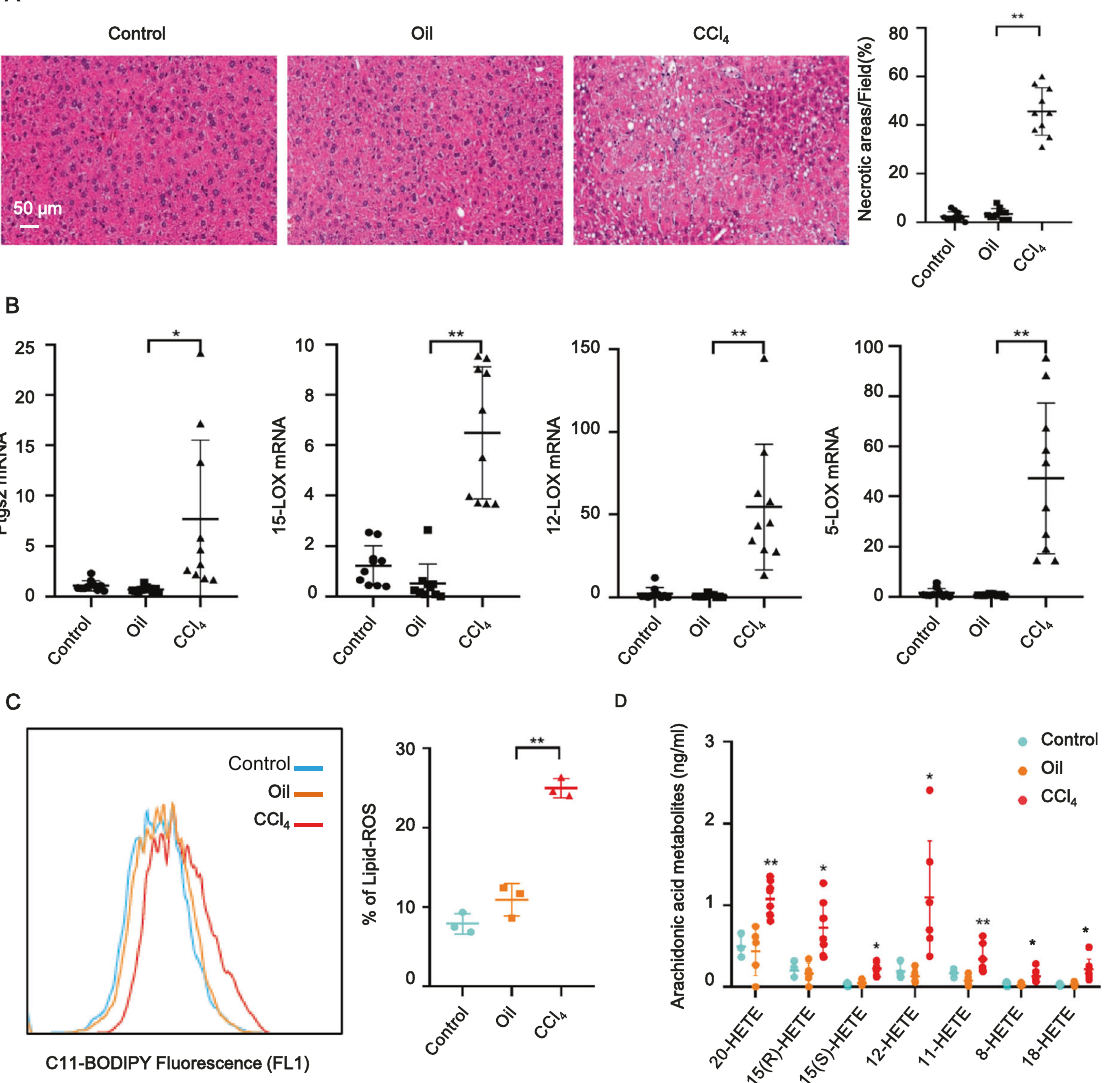
Fig. 1 Ferroptosis occurred in livers of ALI mouse models. A Hematoxylin and eosin (HE) staining showed that administration of CCl 4 induced ALI in mice. B Ptgs2, 15-LOX, 12-LOX , and 5- LOX mRNA levels were measured in livers of 8-week-old male C57BL/6 mice treated for 6 h with or without CCl 4 . mRNA levels were normalized to that of GAPDH and were expressed relative to the mean value in the PBS-treated mice. C Lipid peroxidation was measured using C11-BODIPY 581/591 staining. D Ultra-performance liquid chromatography-tandem mass spectrometry (UPLC-MS/MS) analysis of 20-hydroxyeicosatetraenoic acid (HETE), 15(R)-HETE, 15(S)-HETE, 12-HETE, 11-HETE, 8-HETE, and 18- HETE were performed in liver tissues. Signi fi cance was calculated using one-way ANOVA with Tukey ’ s post hoc test. * p < 0.05 or ** p < 0.001 indicated a signi fi cant difference between